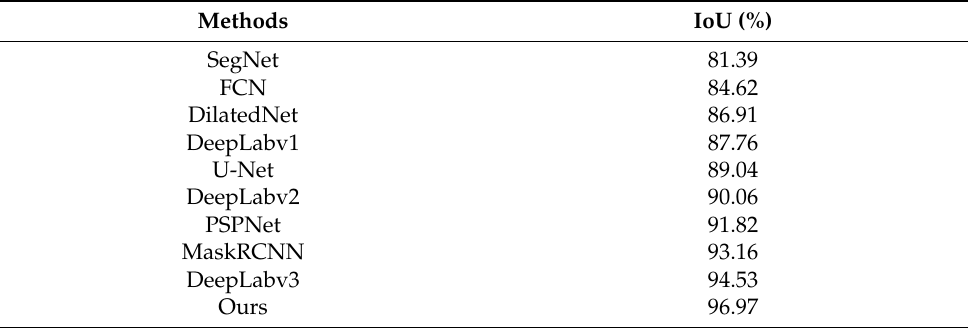
Table 9. Experimental results of ME-Net and other